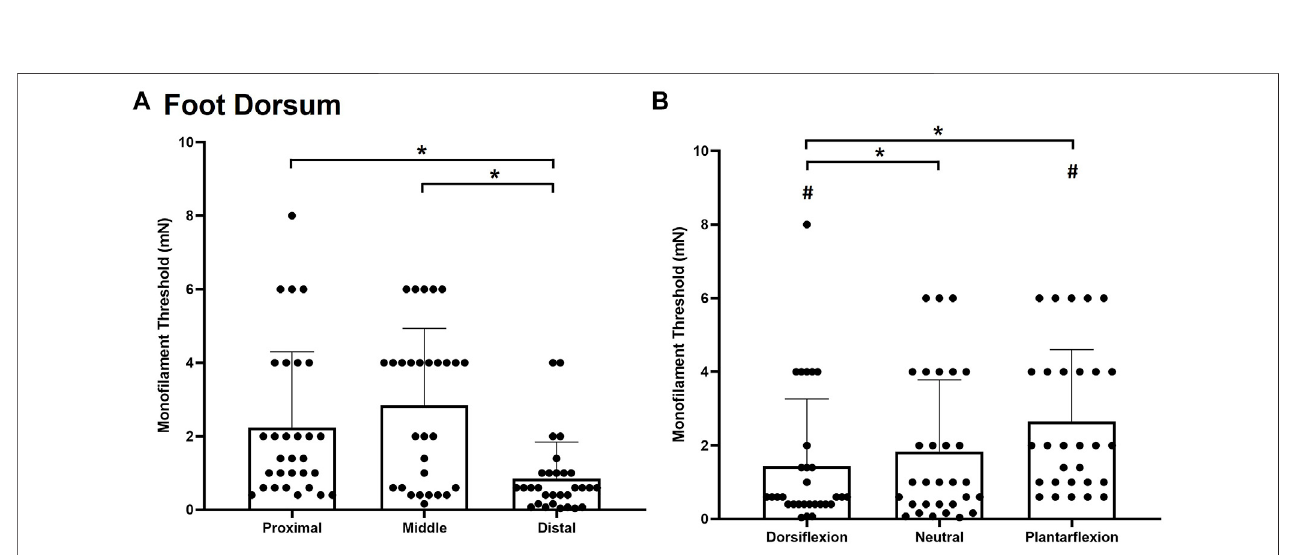
FIGURE4| Mean(+SD)touchmono fi lamentthresholdatthetestsitesonthefootdorsum (A) andanklejointpostures (B) .Asterisksindicateasigni fi cantdifference ( p < 0.05). Pound symbols indicate a signi fi cant difference from the neutral posture (B) ( p < 0.05). Dots represent threshold values for each participant.